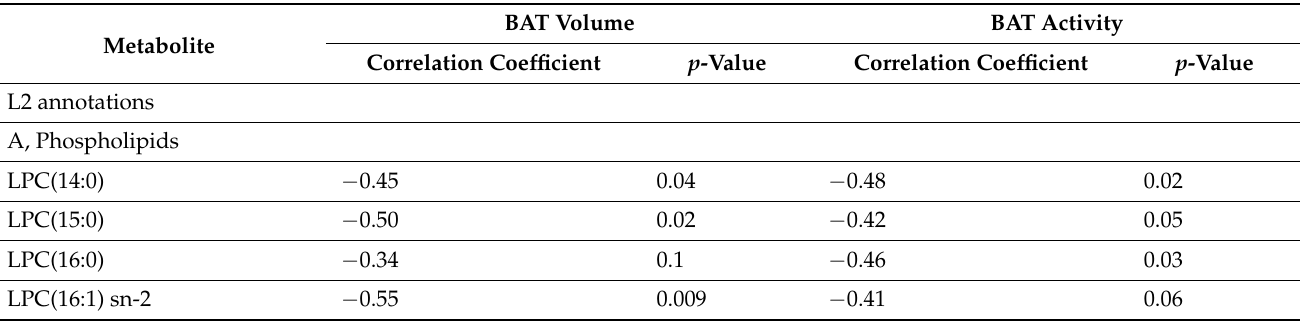
Figure 5. The pathway analysis of all significant metabolites: 1—Linoleic acid metabolism; 2—Bio- synthesis of unsaturated fatty acids; 3—Sphingolipid metabolism; 4—Glycerophospholipid metab- Table 2. Plasma metabolites correlating with the activity and/or the volume of